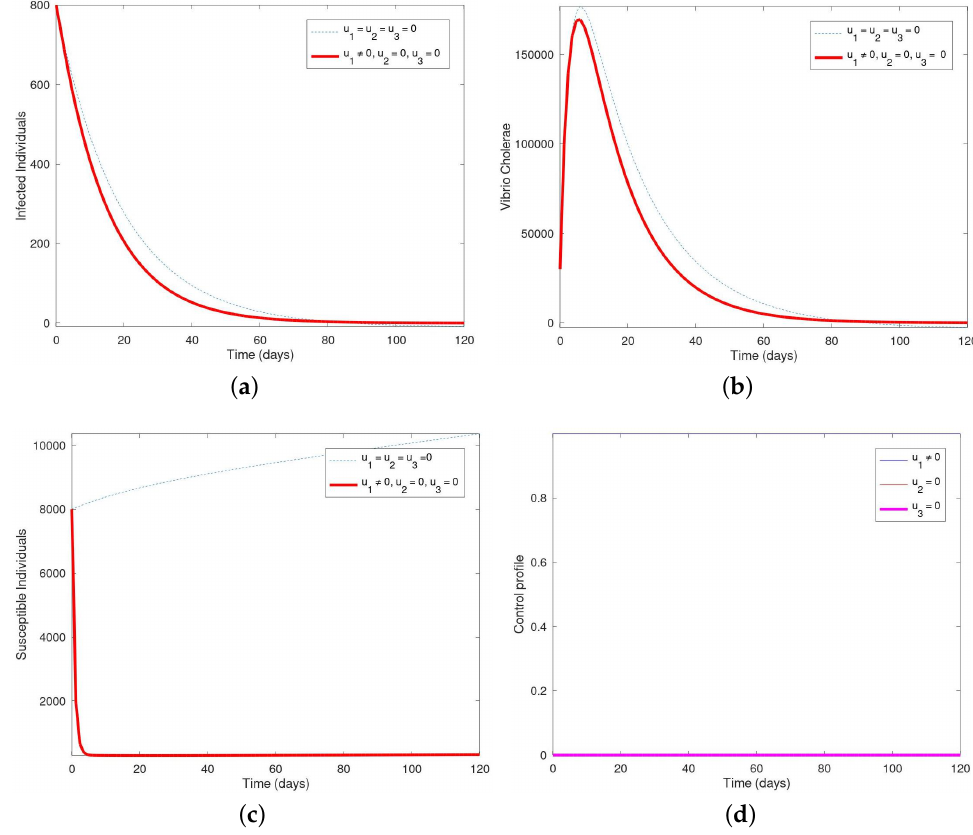
Figure 1. Simulation showing the population of ( a ) infected, ( b ) vibrio cholerae, ( c ) susceptible and ( d ) the control profile with ( u 1 ) only, where in Figure 1a, the infected human population decreases sharply over time. In Figure 1b, the population of vibrio cholerae increased within the first 20 days but dropped very sharply and wiped out completely until the end of 120 days. In Figure 1c, it was observed that the susceptible human population decreases with the control intervention u 1 in place but increases without the control. The control profile in Figure 1d shows that the control u 1 , remained stable from day 1 till the end of the 120 days while the others ( u 2 and u 3 ) maintained lower